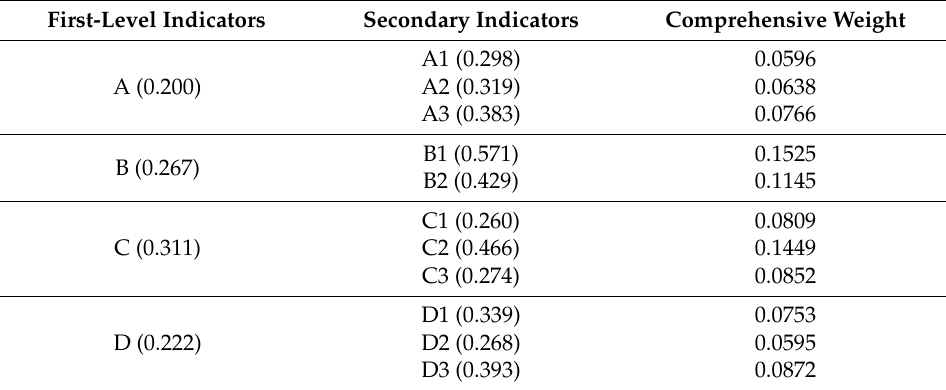
Table 12. Weight obtained by using granular